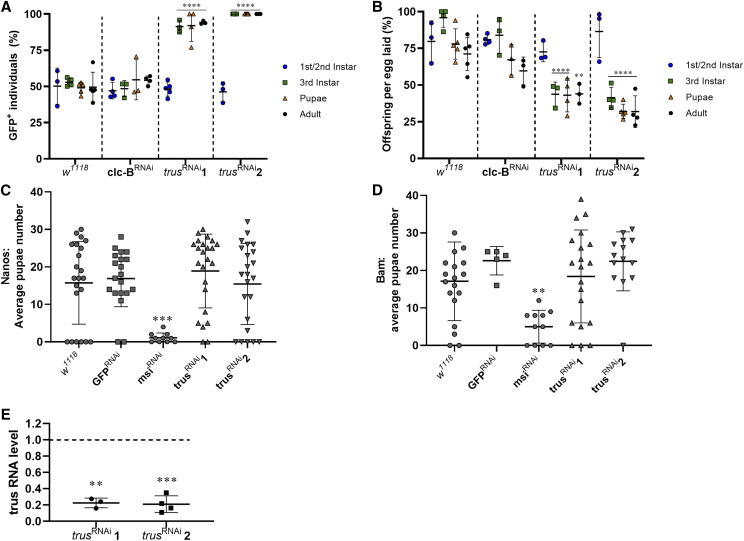
Ubiquitous knockdown of the PDCD2L fly ortholog trus causes lethality but does not affect germ cell specific development. A) Developmental rate and B) GFP+ rate (RNAi element absent) of individuals from each line crossed to Tub-Gal4 with GFP balancer. Fertility was tested in males with germ cell-depleted trus levels, using Nanos (C) and Bam (D) drivers, through counting pupae generated after mating with w1118 females. Each data point represents a single vial counted. ** P < 0.01, *** P < 0.001, **** P < 0.0001 compared to w1118 at corresponding developmental stage. E) Knockdown efficiency of each trus RNAi line as measured by quantitative PCR, normalized to RpL23. ** P < 0.01, *** P < 0.001 compared to wildtype.